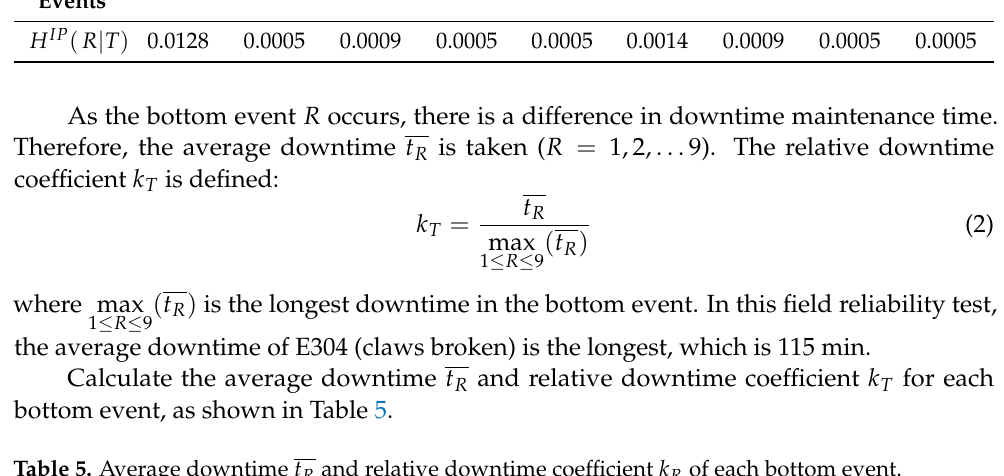
Table 5. Average downtime t R and relative downtime coefficient k R of each bottom event.